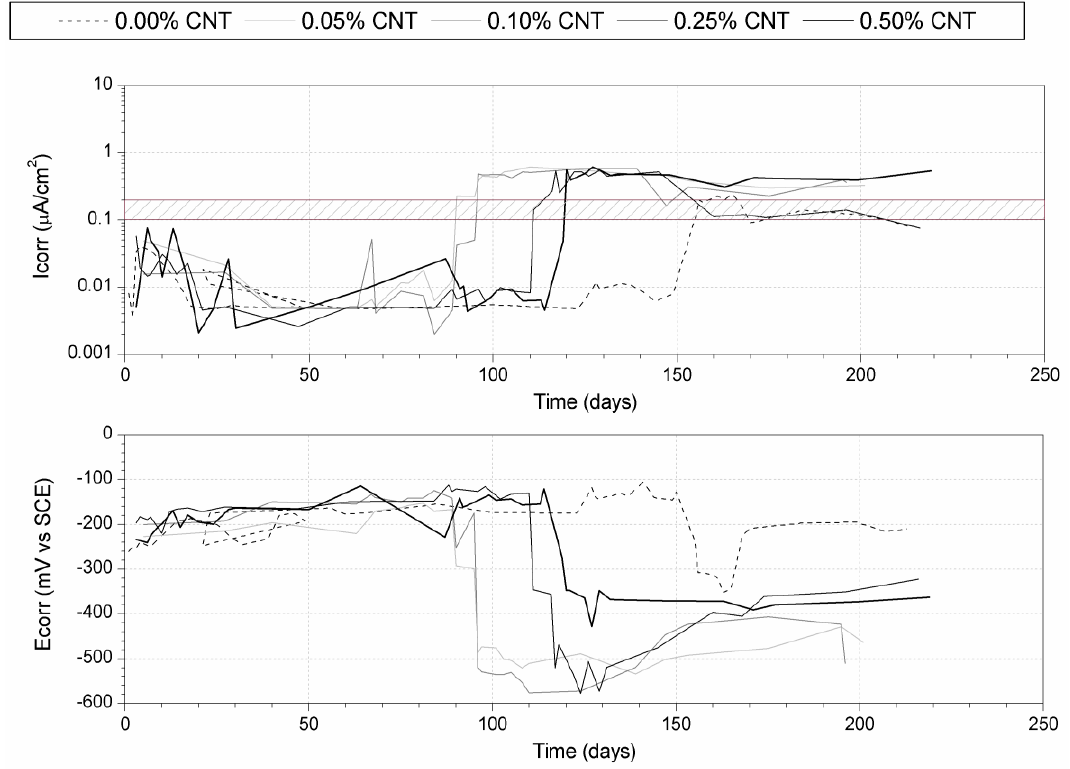
Figure 4. Evolution of corrosion potential ( E embedded in CNT cement pastes partially immersed in